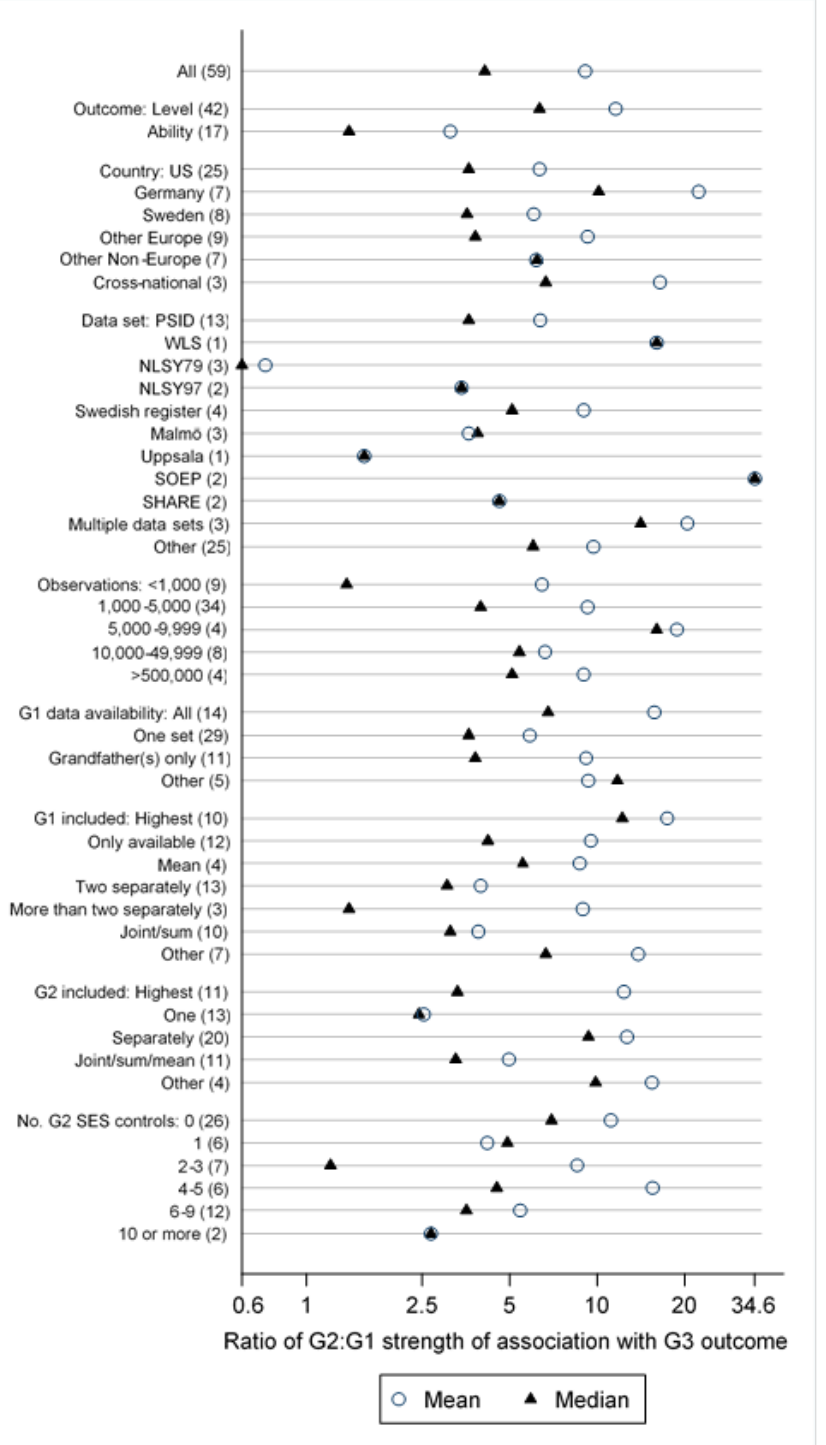
Figure 3: Ratio of G2:G1 (parent to grandparent) strength of association with G3 (grandchild) outcome: mean and median by analysis characteristics. Notes: The number of observations in each category is included in parentheses. A larger number corresponds to a stronger G2–G3 association relative to the G1–G3 association. sociological science | www.sociologicalscience.com